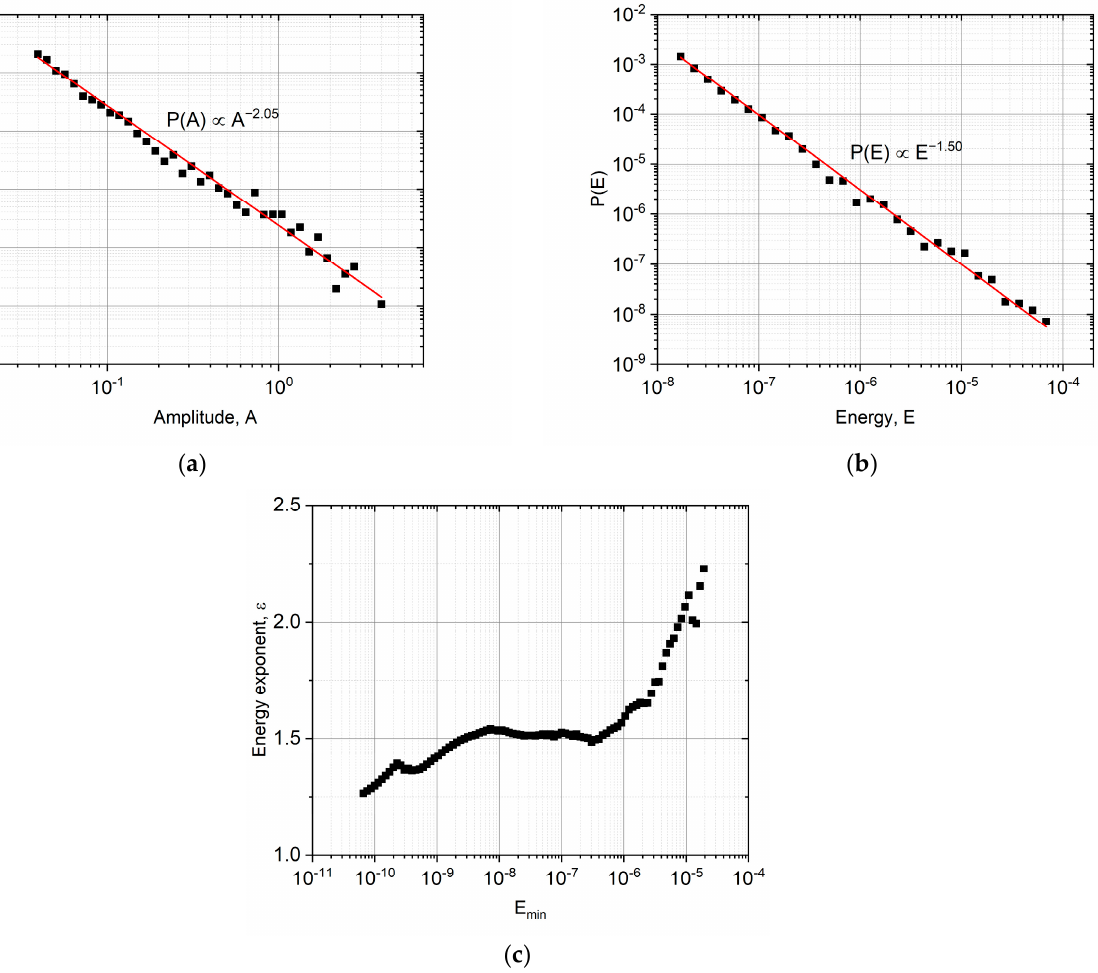
Figure 4. Probability density functions for the avalanche amplitude ( a ) and energy ( b ). ( c ): Maximum likelihood estimation for the energy power exponents.